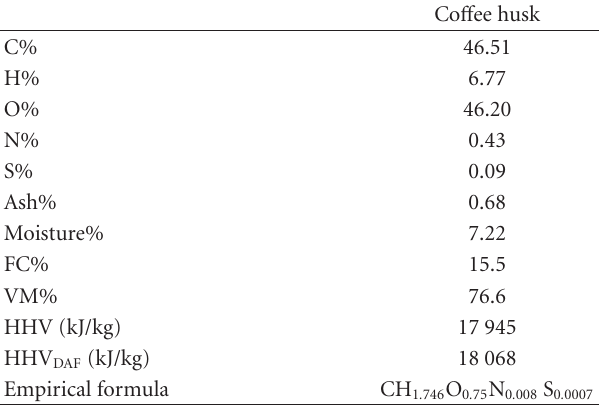
Table 3: Ultimate (DAF basis) and proximate analysis of co ff ee husk biomass.